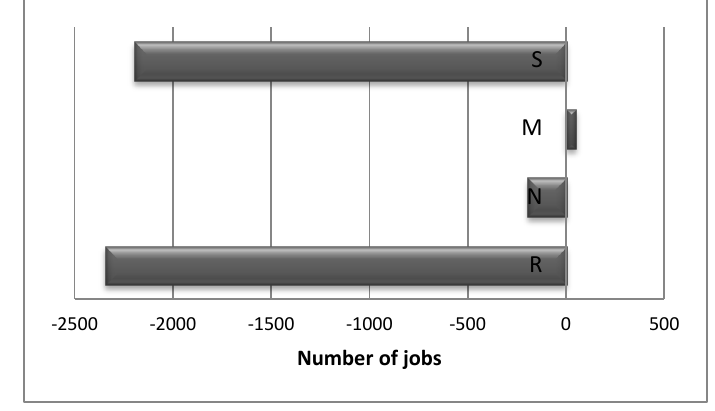
FIGURE 2: Shift-Share Analysis of Employment in the SDM Source: Authors’